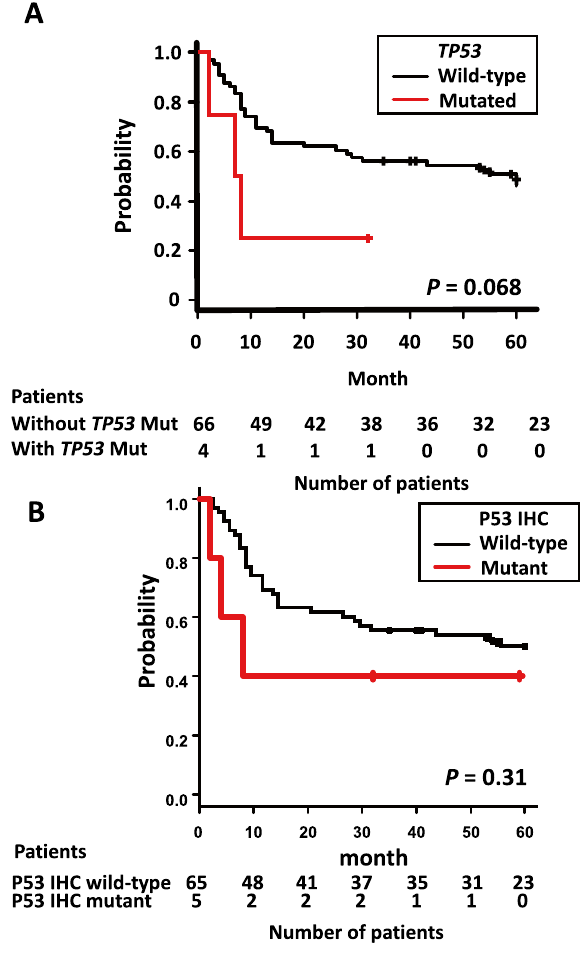
Figure 2. Kaplan–Meier survival curves according to TP53 status and HPV genotypes. ( A ) Progression- free survival between TP53 wild-type (black line) and TP53 mutants (red line), ( B ) Progression-free survival between TP53 wild-type of IHC (black line) and TP53 mutant of IHC (red line), and ( C ) Progression-free survival between HPV16/18-positive (black line) and non-HPV16/18 (red line) patients.